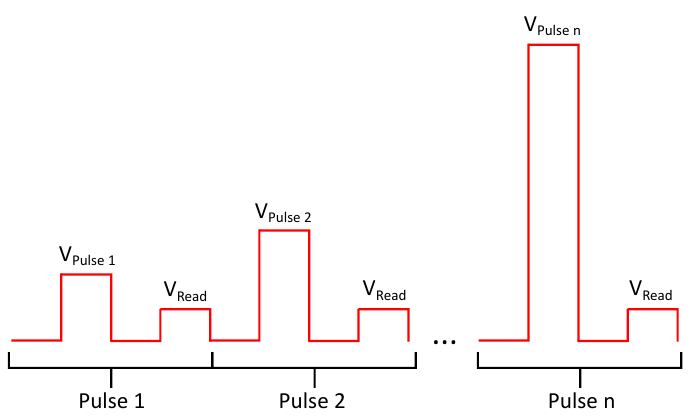
Figure 4. Illustration of programming algorithm (modified from